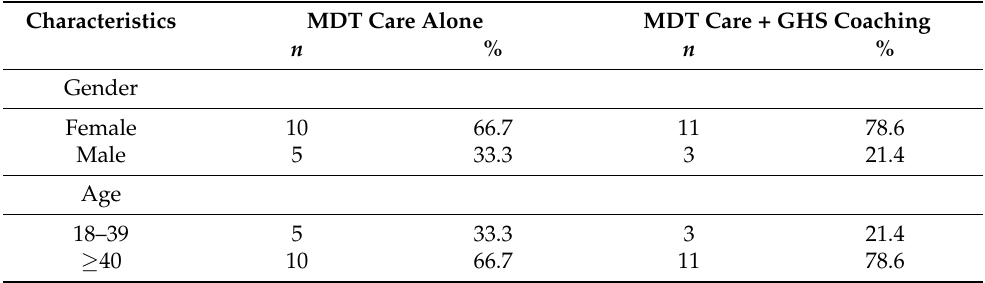
Table 1. Participant characteristics at baseline.